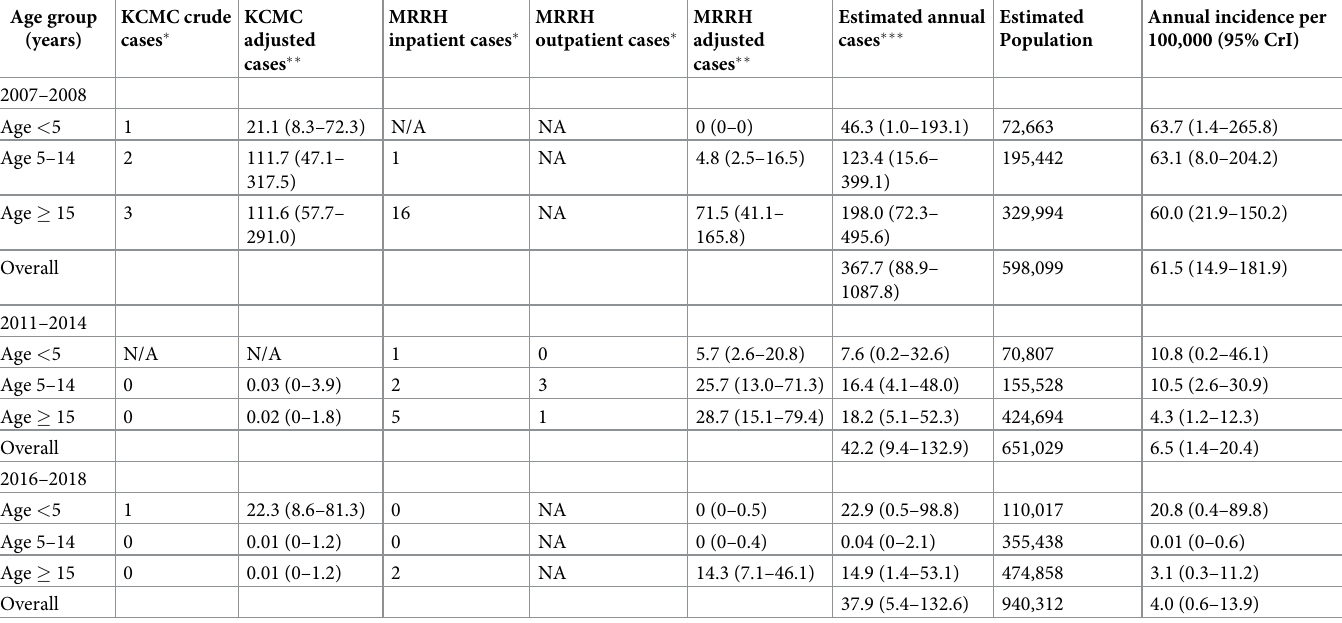
Table 4. Typhoid fever incidence estimates, Kilimanjaro Region, Tanzania,